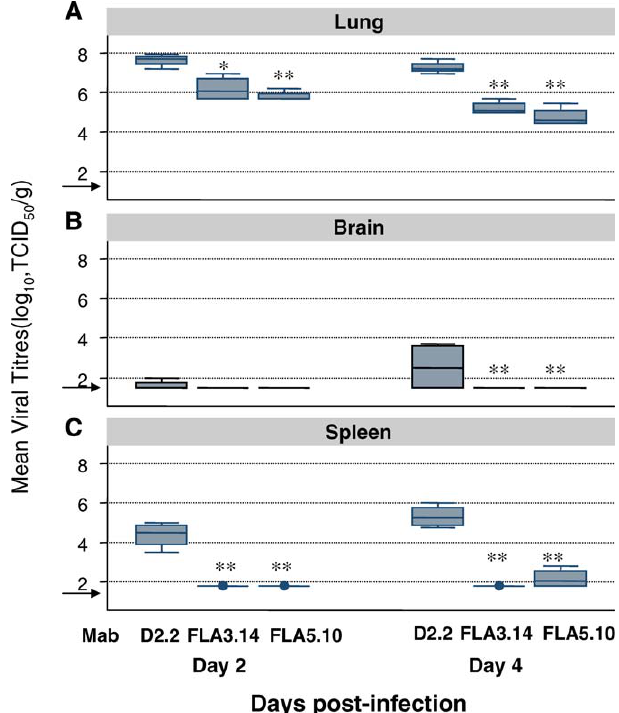
Figure 2. Pulmonary Virus Titers and Extrapulmonary Dissemination of A/Vienam/1203/04 (H5N1) Following Passive Immunization The data depict the mean ( 6 interquartile range) viral titer in (A) lungs, (B) brain, and (C) spleen of groups of five BALB/c mice passively immunized by i.p. injection of mAbs FLA3.14, FLA5.10, or the control mAb D2.2, then challenged i.n. with 50 l l of A/Vietnam/1203/04 (10 5 TCID 50 /mouse) 24 h later. On days 2 and 4 there was significantly less virus recovered in splenic and pulmonary tissue of mice that had received either FLA3.14 or FLA5.10 than mice that had received the control mAb, D2.2. (* p , 0.01 versus D2.2; ** p , 0.001 versus D2.2). The lower limit of detection (1.5 log 10 TCID 50 /g) is shown by the arrow.